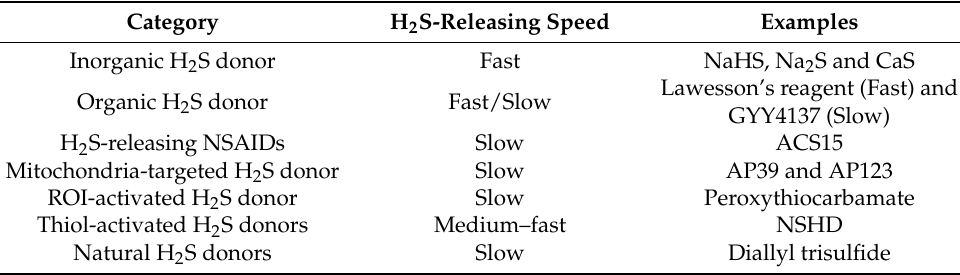
Table 2. A brief summary of common H 2 S donor